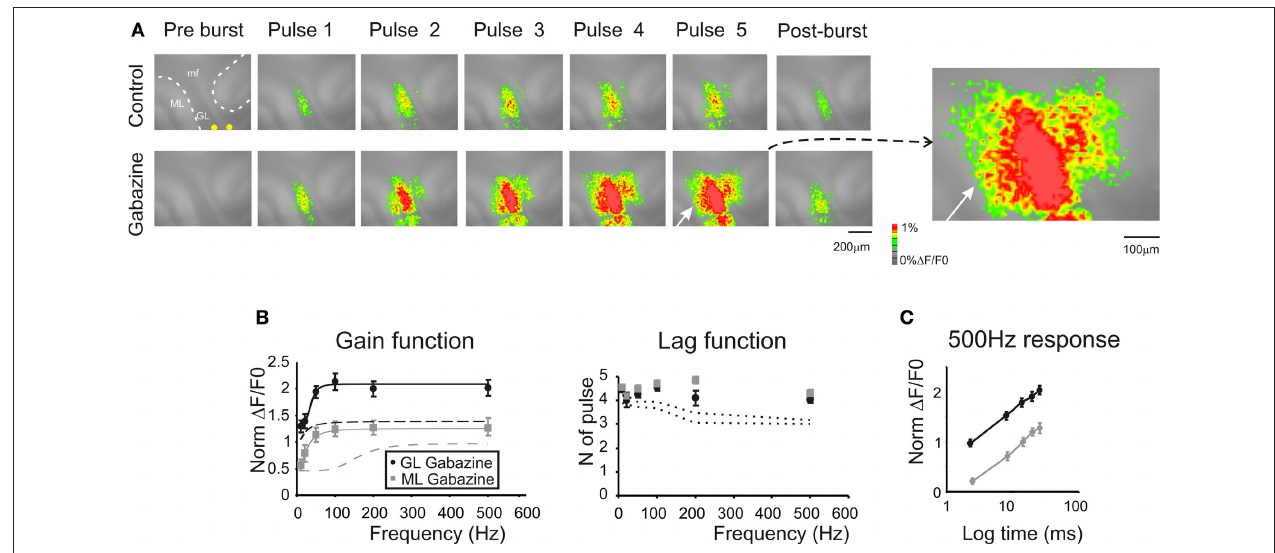
FiGure  | regulation of frequency-dependence by GABA-A receptors. (A) Optical maps were obtained at the peak of responses in 5-pulse 100 Hz bursts delivered to the white matter. Application of 10-μM gabazine markedly enhanced amplitude and extension of responses in the granular and molecular layer, and the effect increased during and after the burst (50 ms after the end of the burst). It should be noted the marked response summation in the presence of gabazine. The enlarged map evidences the activation of the molecular layer (white arrow) following the application of 10-μM gabazine. (B) Maximum response amplitudes were measured for each of the five pulses of bursts